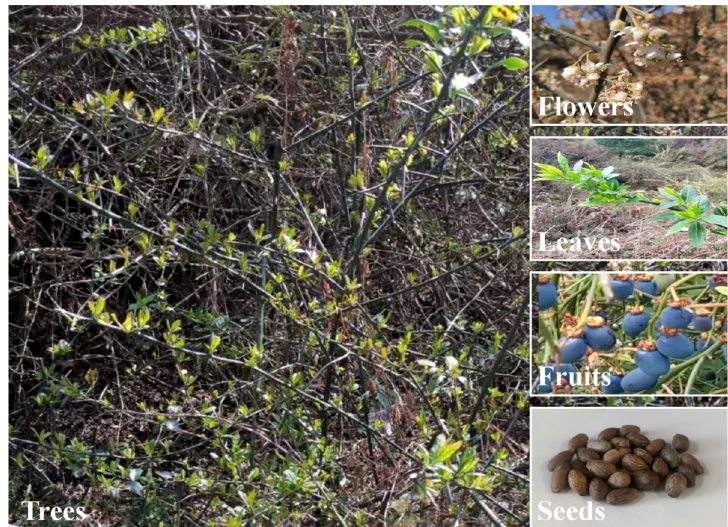
Figure 1. Picture with Prinsepia utilis Royle trees, flowers, leaves, fruits and seeds.